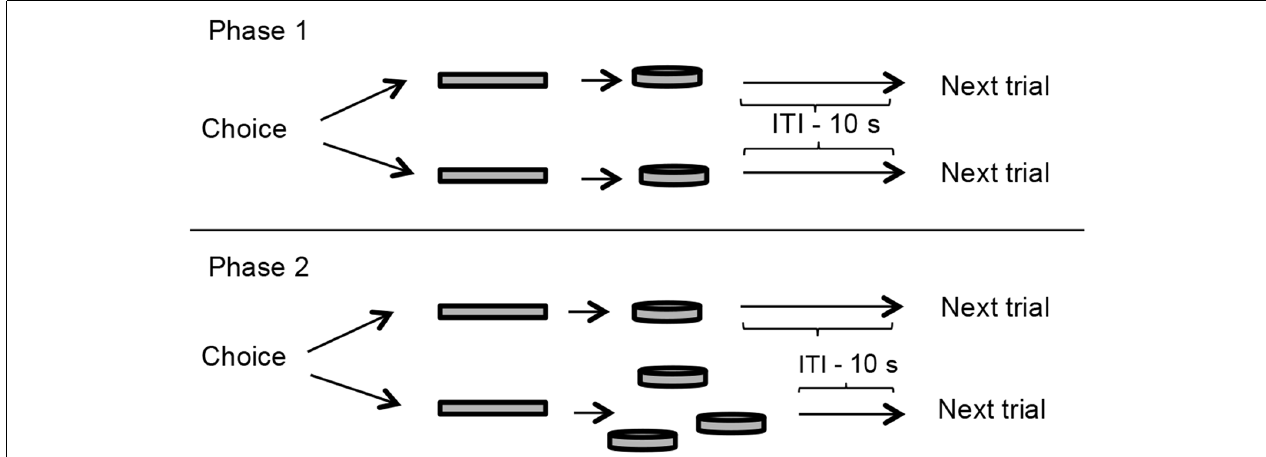
FIGURE 1 | Pre-training outline. In phase 1 (upper panel), two levers (represented by rectangles in this diagram) were presented to the rats, both delivered one food pellet immediately after a press, but only one could be pressed in every trial. The goal of this phase was to measure the lever-bias of each rat, and it lasted one session. Phase 2 (lower panel) was a preference test for the large reinforcer. One of the levers delivered one food pellet and the other delivered three food pellets, both immediately. This phase lasted 10 sessions or until the subject reached the criterion of 66% of the choices to the large reinforcer in three consecutive sessions. Presentation of food pellets was followed by a 10-s inter-trial interval (ITI) in which levers were retracted.